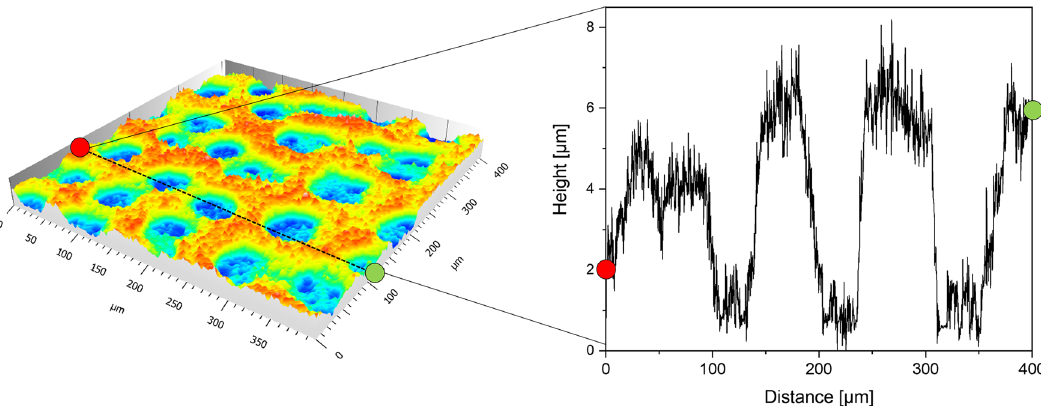
Fig. 7 Partial 3D reconstruction of a foam electrode and the pro fi lometric information gained by a horizontal line scan along the x -axis. The information of an area of 400 µ m × 400 µ m, obtained by laser confocal scanning microscopy was taken to calculate the macro porosity of all tested